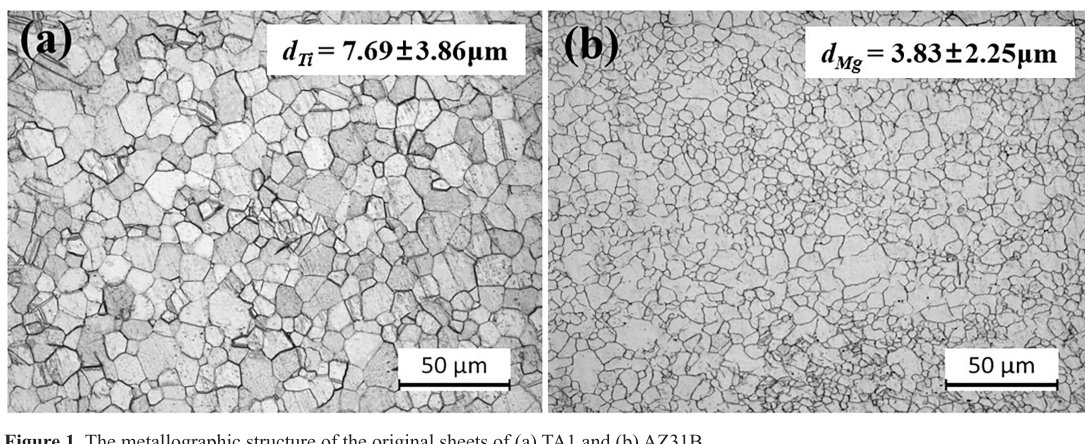
Figure 1. The metallographic structure of the original sheets of (a) TA1 and (b) AZ31B.